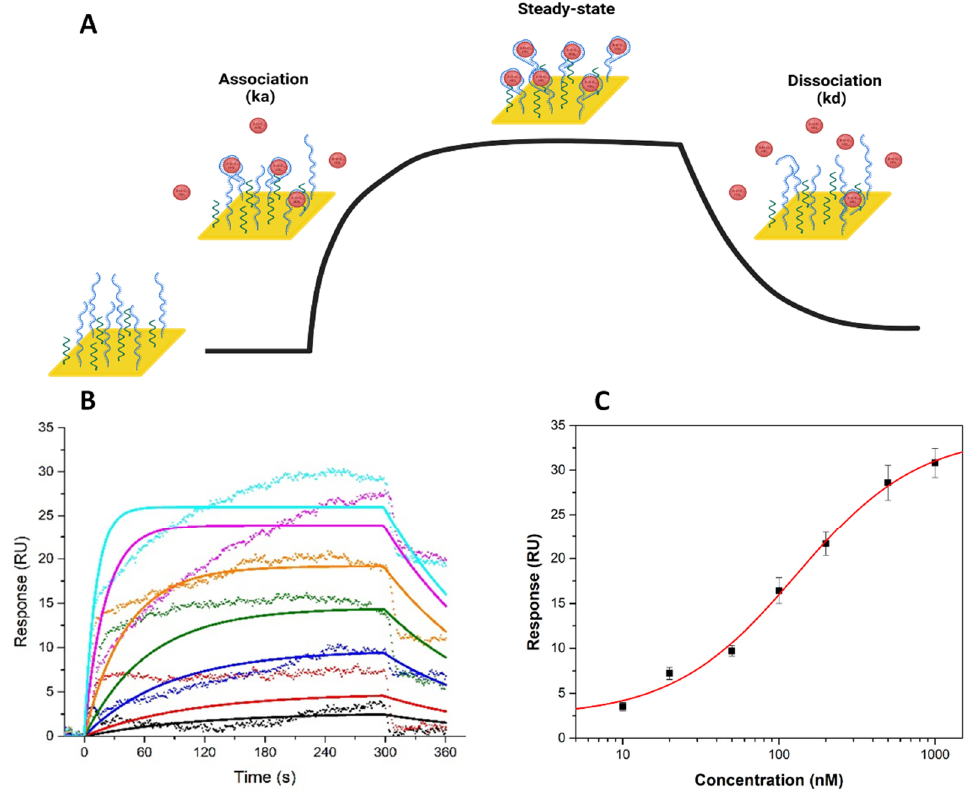
Figure 9. SPR characterization of the interactions between 3-O-C 12 -HSL and the selected APT: Schematic representation of the SPR-based APT binding assay. Created with BioRender.com ( A ). The kinetic analysis of 3-O-C 12 -HSL-APT binding behavior; representative normalized, blank- subtracted SPR sensorgrams for seven serial concentrations of 3-O-C 12 -HSL ( 10 nM , 20 nM , 50 nM , 100 nM , 200 nM , 500 nM, and 1000 nM ) ( B ); the experimental points obtained (scatter) and the fitted curves (straight lines) (corresponding to a 1:1 kinetic binding model), and The corresponding equilibrium binding curve (fitted to a steady-state affinity model) ( n = 3 ) ( C ). Experimental conditions: 60 µ L/min flow rate, injections of 300 s, 60 s dissociation time.